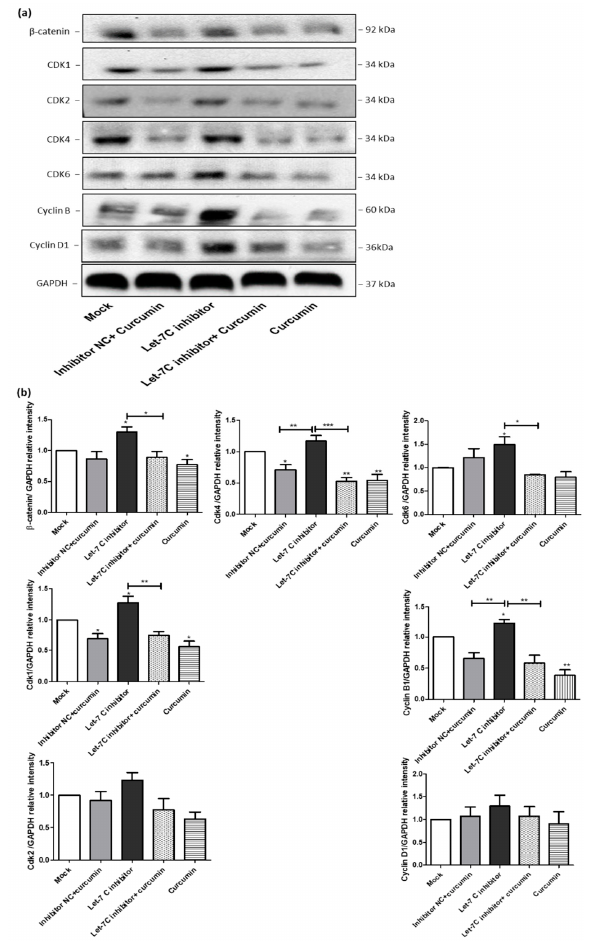
Figure 7. Effect of let7C inhibition on cell cycle regulating proteins. ( a ) A representative western blot is shown from three independent let-7C transfection experiments where expression of β -catenin, CDK1, CDK2, CDK4, CDK6, cyclin B and cyclin D1 was examined. ( b ) Band intensity of the indicated proteins were quantified densitometrically, normalised to glyceraldehyde-3-phosphate dehydrogenase (GAPDH) level and expressed as the mean relative intensity ± SEM ( n = 4). * p < 0.05, ** p < 0.01, and *** p < 0.001. ONE-WAY ANOVA was used to analyse the